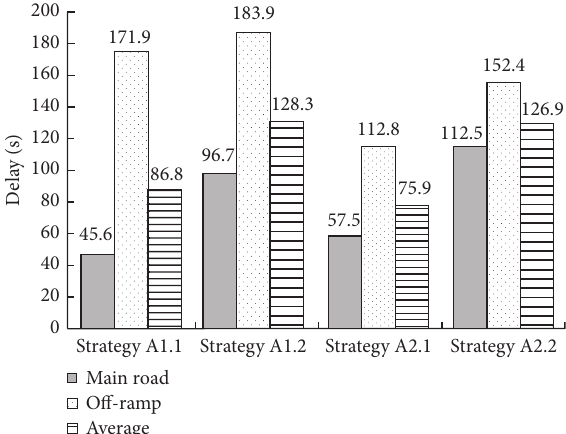
Figure 12: Vehicle delays comparison with main road flow 1800veh/h/lane and off-ramp rate 40%.